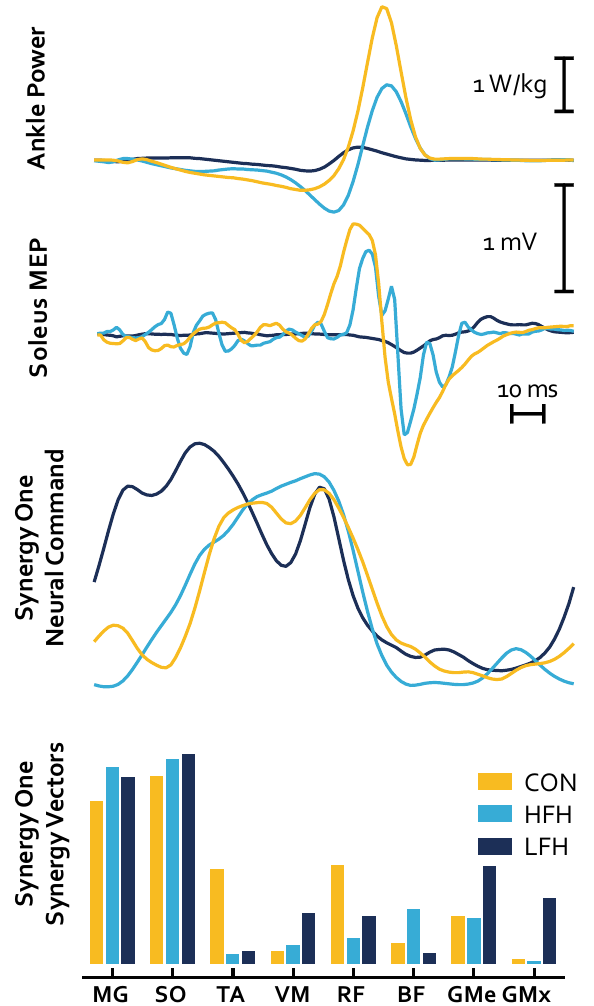
Figure 7. Example behavior of representative subjects for CON (gold), HFH (light blue), and LFH (dark blue). The 1st row represents ankle power, the 2nd row represents an MEP derived from TMS during the pre-swing phase of walking, the 3rd row is a representative Plantarflexion Neural Command over the full gait cycle, and the 4th row is a representative Plantarflexion Synergy